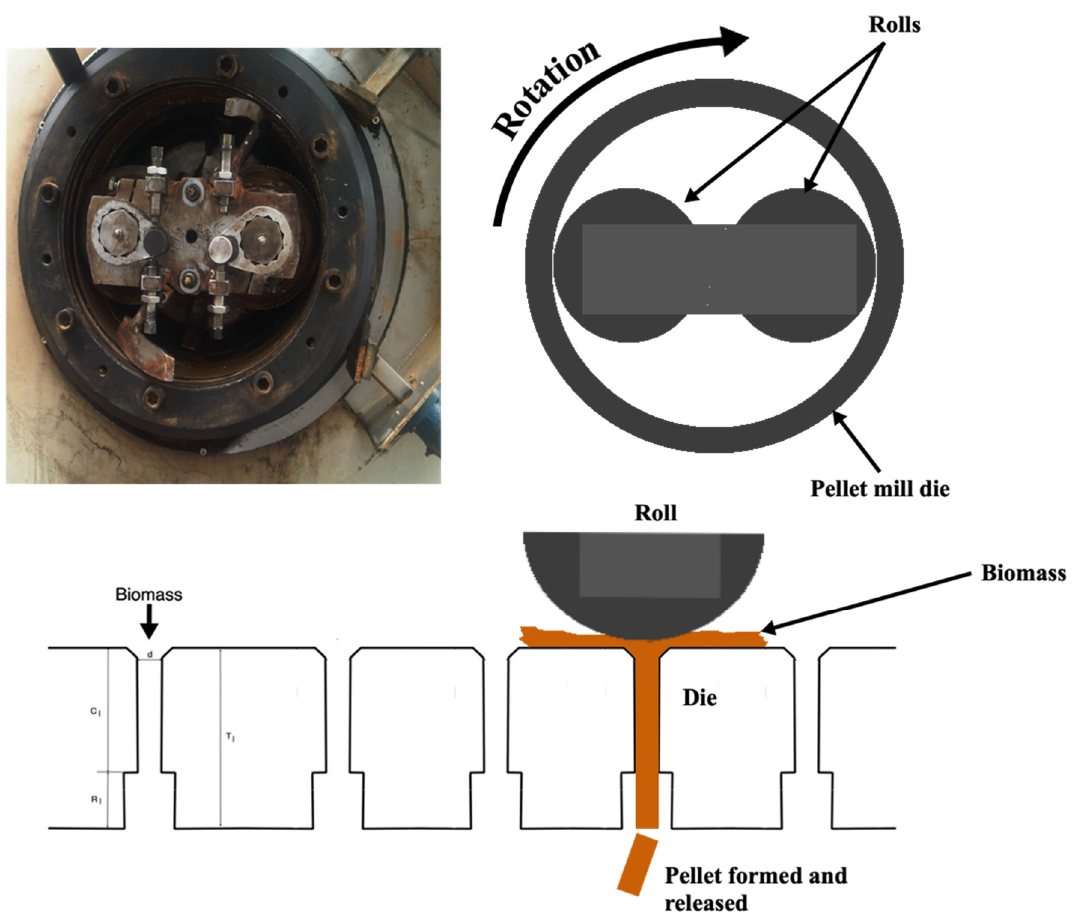
Figure 10. Scheme of the relationship between the constituent parameters between the holes in a pellet mill die, where C l is the compression length, R l is the relief length, T l is the total length and d is the diameter.